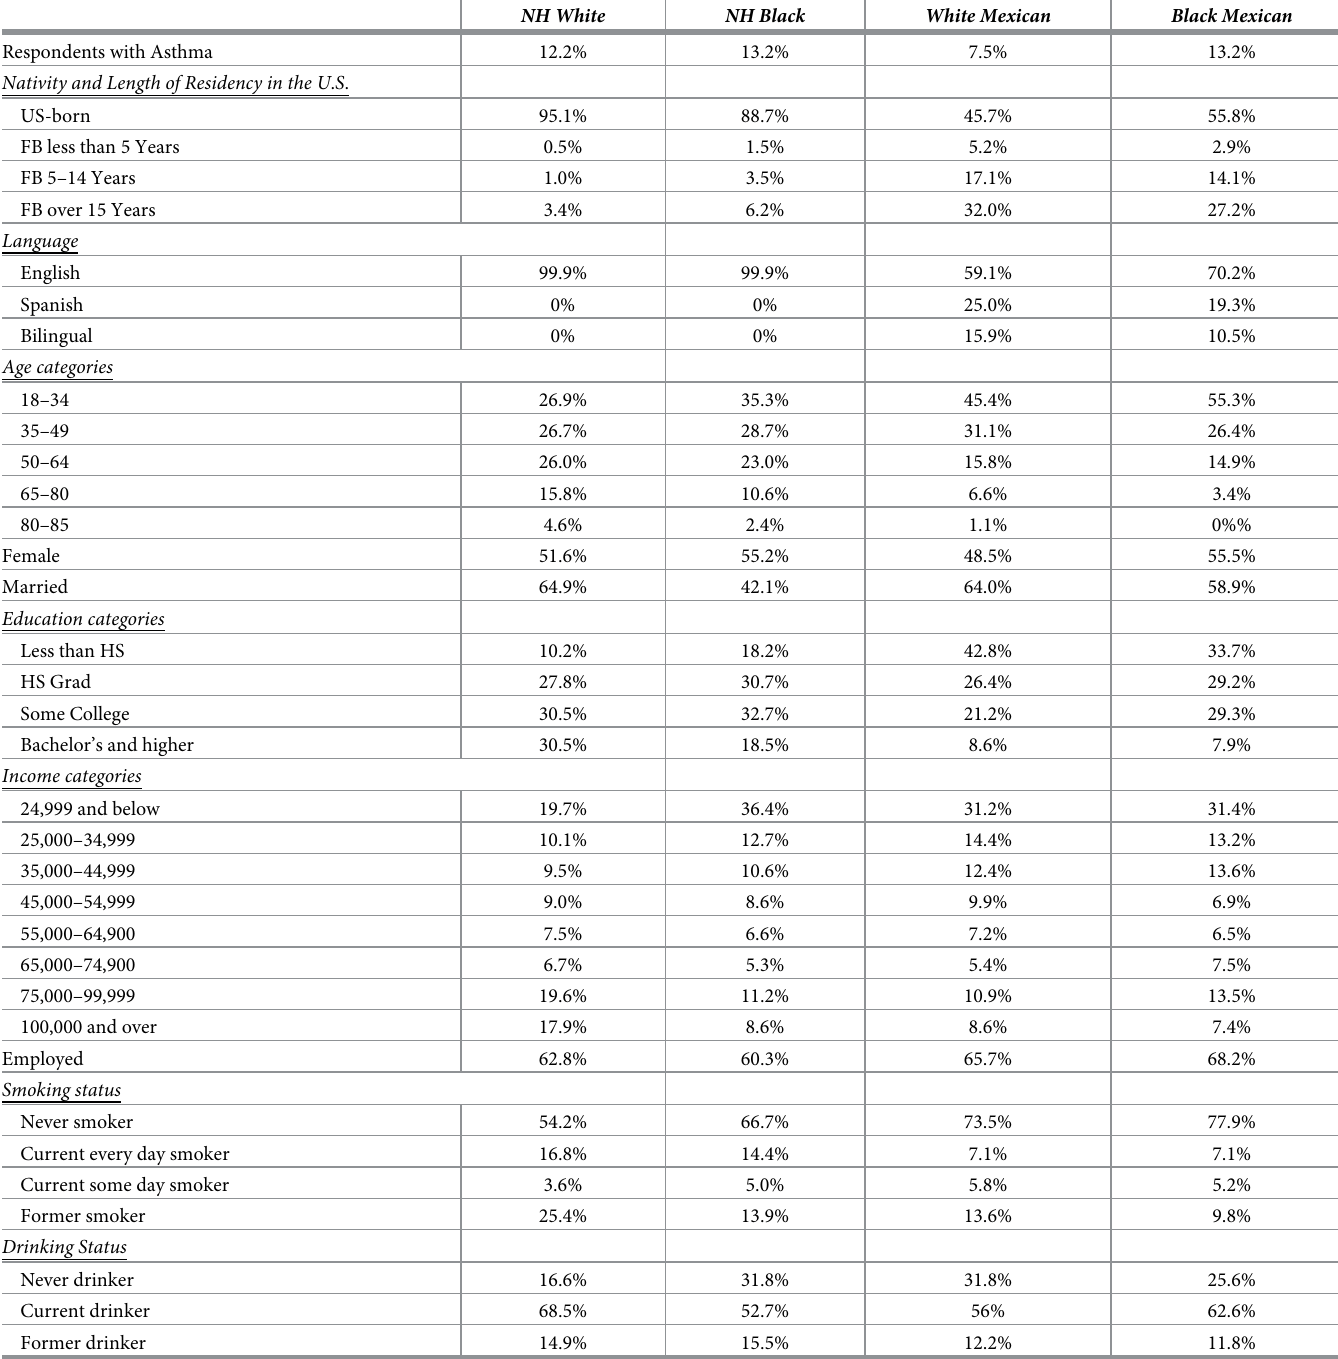
sample characteristics and Tables 2 and 3 display the multivariable analyses. In the first set of multivariable models (Table 2), I include in the analysis White Americans, Black Americans, Table 1. Percentage distributions of sample respondents by racial/ethnic categories across all variables of